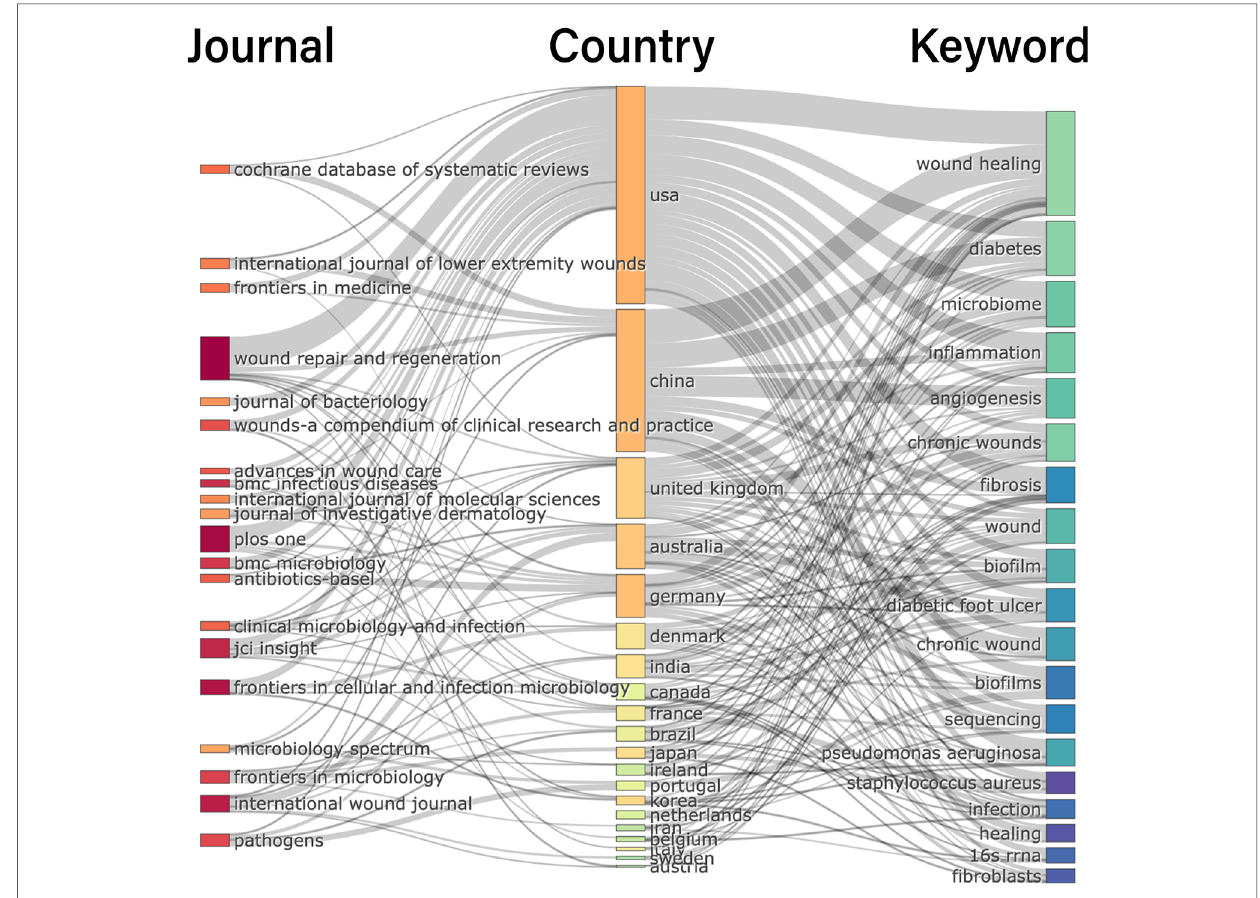
FIGURE 9 Three- fi eld plot of analysis countries, keywords and journals about HTS technology associated with chronic wounds (middle fi eld: countries, left fi eld: journals, right fi eld: